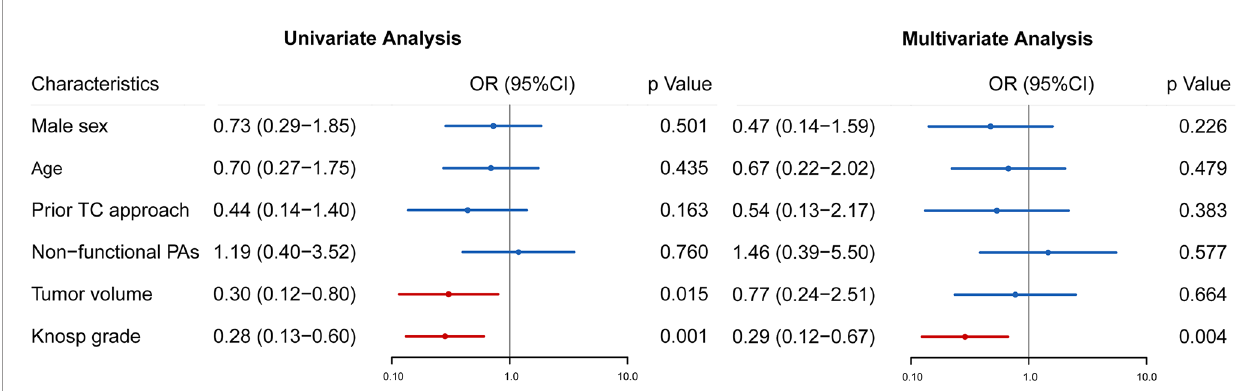
FIGURE 3 | Univariate and multivariate analyses were performed to identify preoperative factors in fl uencing GTR in patients with rrPAs. Odds ratio (OR), 95% con fi dence intervals (CI) and p value are exhibited for